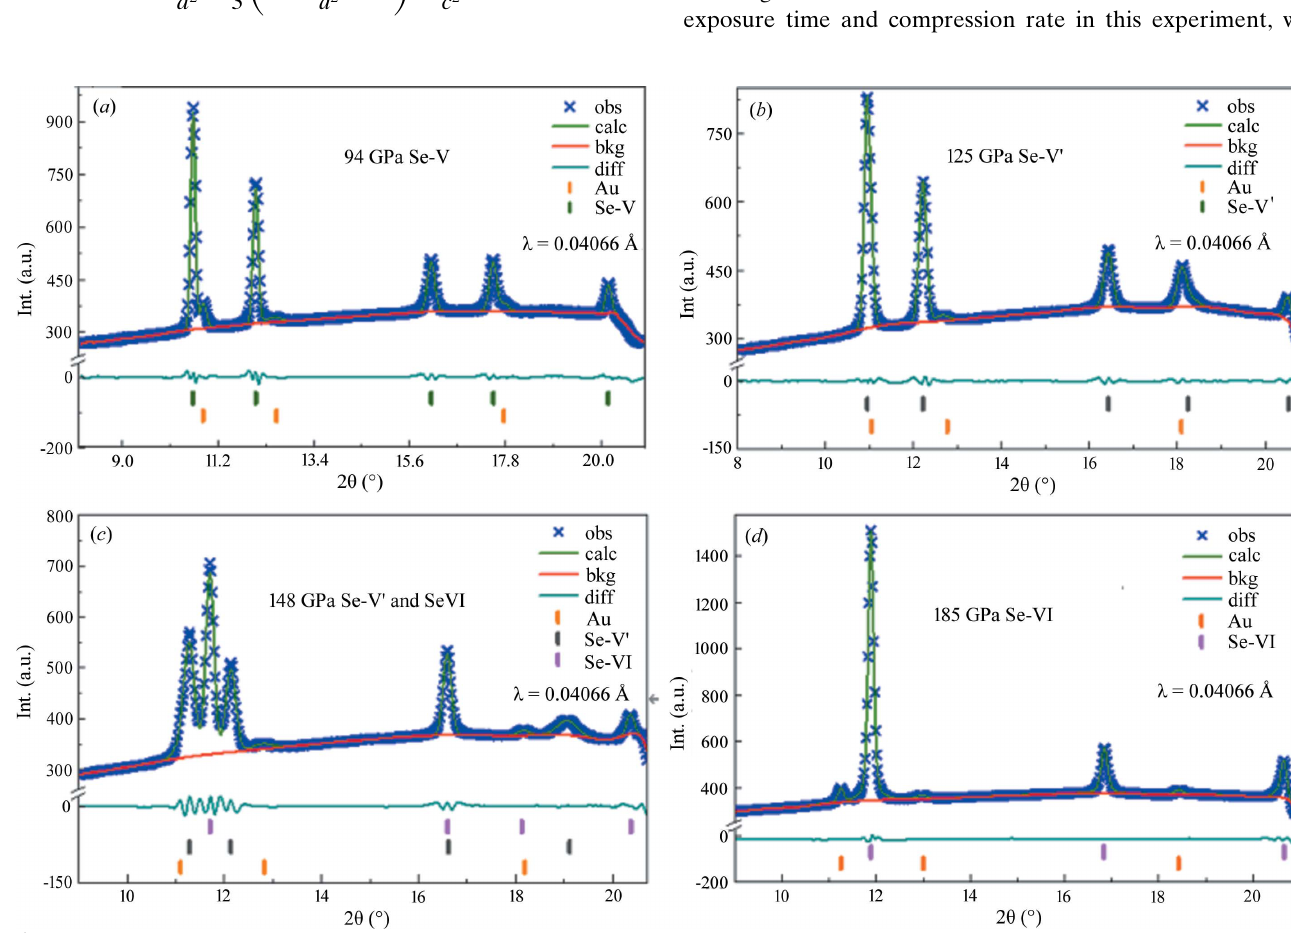
Figure 2 Representative Rietveld refined diffraction patterns and fitting results of ( a ) Se-Vat 94 GPa, with a = 3.8687 (6) A˚ and c = 2.9086 (2) A˚ ( W R = 1.17%, (cid:4) 2 = 25.6564, GOF = 0.23); ( b ) Se-V 0 at 125 GPa with a = 3.8205 (18) A˚ and c = 2.7760 (3) A˚ ( W R = 0.94%, (cid:4) 2 = 17.3023, GOF = 0.18); ( c ) Se-V 0 with a = 3.8450 (30) A˚ and c = 2.6371 (6) A˚ , Se-VI with a = 2.8191 (6) A˚ at 148 GPa ( W R = 1.06%, (cid:4) 2 = 20.719, GOF = 0.21); and ( d ) Se-VI at 185 GPa, with a = 2.7755 (5) A˚ ( W R = 2.12%, (cid:4) 2 = 87, GOF =